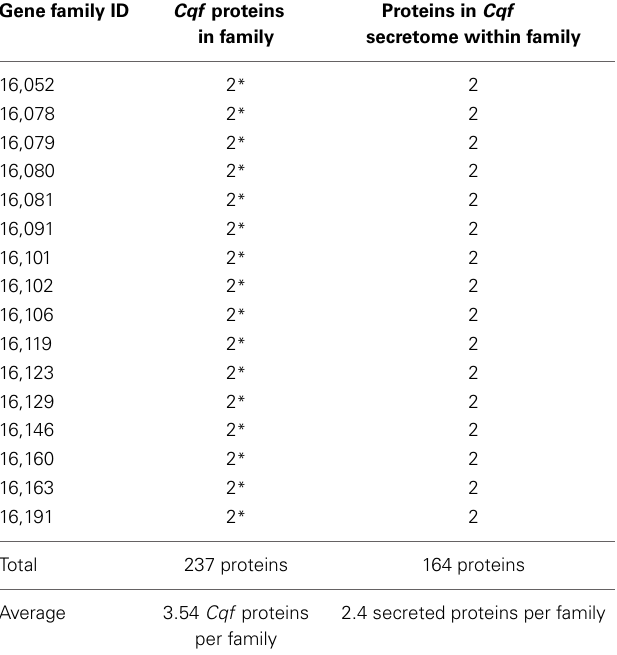
Table 2 | Potential sub- and neo-functionalization within Cqf- specific putative effector